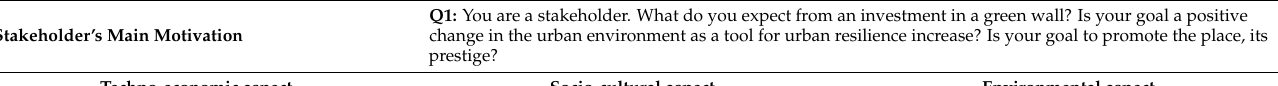
Table 3. An overview of the questions for the stakeholders: Guided interview for stakeholder’s motivation. The questions are designed to guide the stakeholder in making decisions about exterior GW and also provide insight into the relative